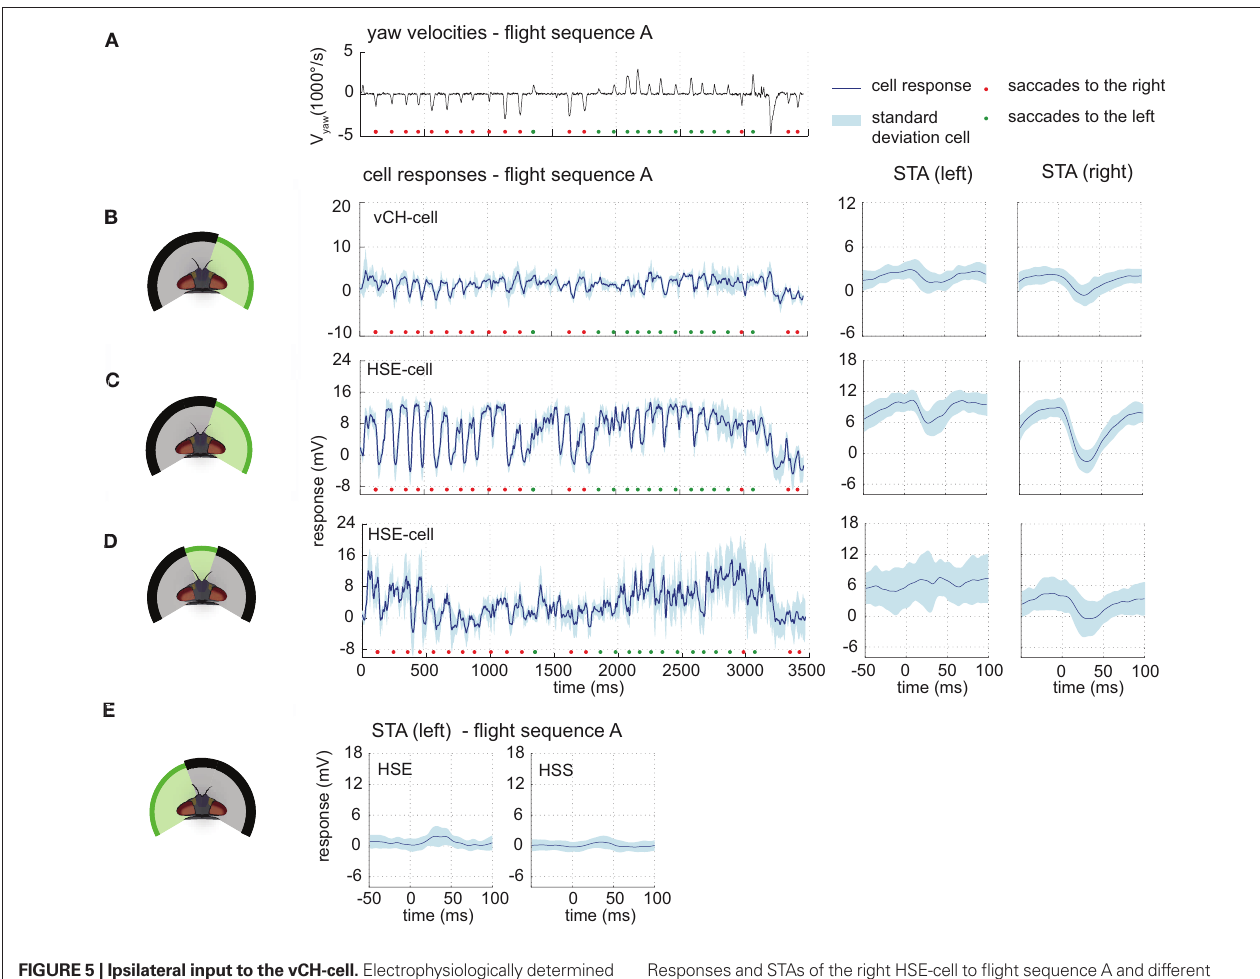
Figure 5 | ipsilateral input to the vCH-cell. Electrophysiologically determined responses of the HS-cells and the vCH-cell to naturalistic motion stimulation of different parts of the visual field. (A) Head yaw velocities plotted against time for flight sequence A. (B) Responses and STAs of the right vCH-cell to flight sequence A. The stimulus is limited to the right part of the visual field. (C,D)